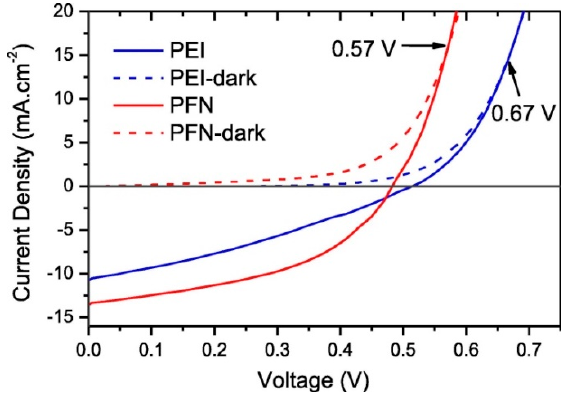
Figure 3. Current density-voltage (J-V) curves of inverted Schottky QDSCs with two different electrolytes. From [59], reprinted with permission. Copyright © Elsevier 2019.